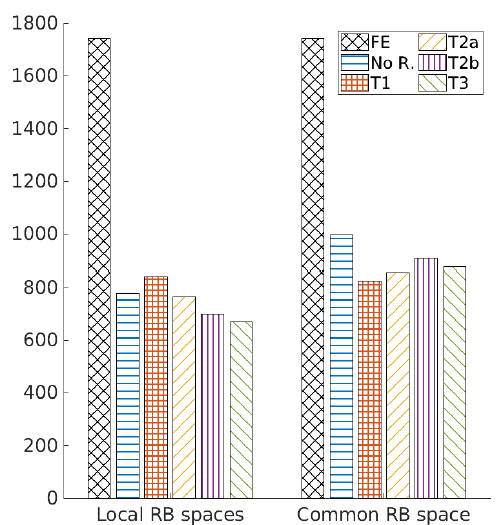
Figure 2. Computational times in seconds for Algorithm 2 with or without basis removal and using the two strategies in Remark 6 for initializing the RB